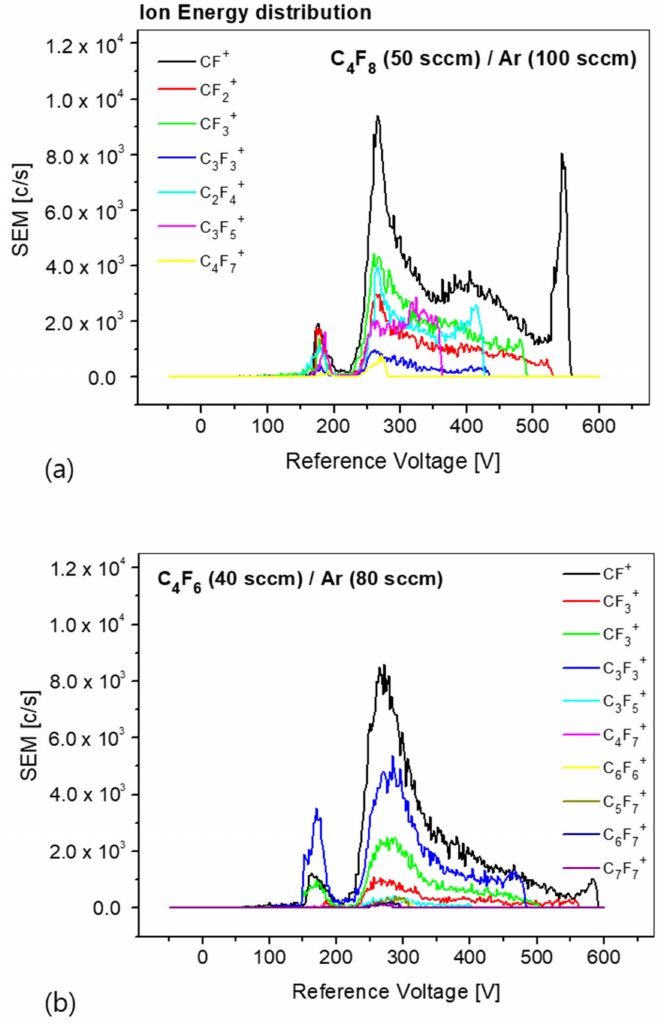
Figure 5. Ion energy distribution at each plasma: ( a ) C 4 F 8 (50 sccm)/Ar (100 sccm) plasma, ( b ) C 4 F 6 (40 sccm)/Ar (80 sccm) plasma, at a fixed pressure of 20 mTorr and an RF power of 300